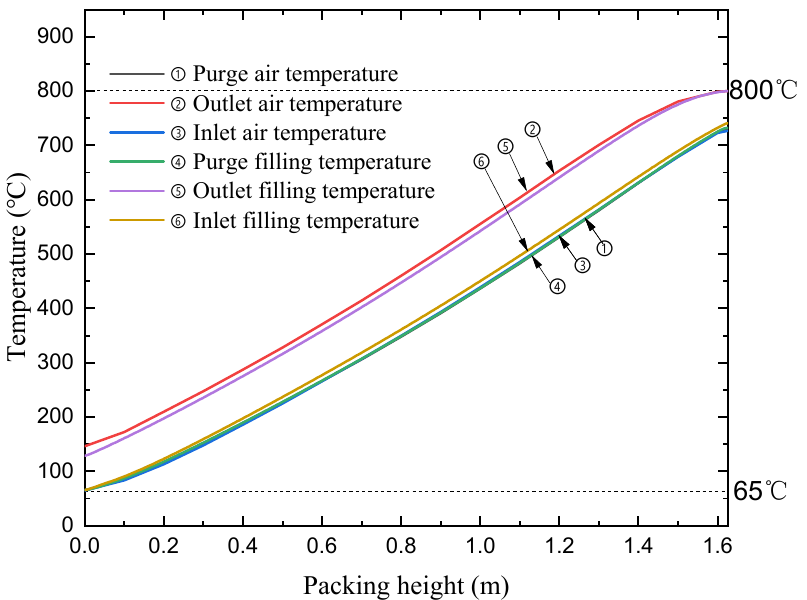
Figure 7. The temperature profile of gases and fillings along with height in a stable cycle.